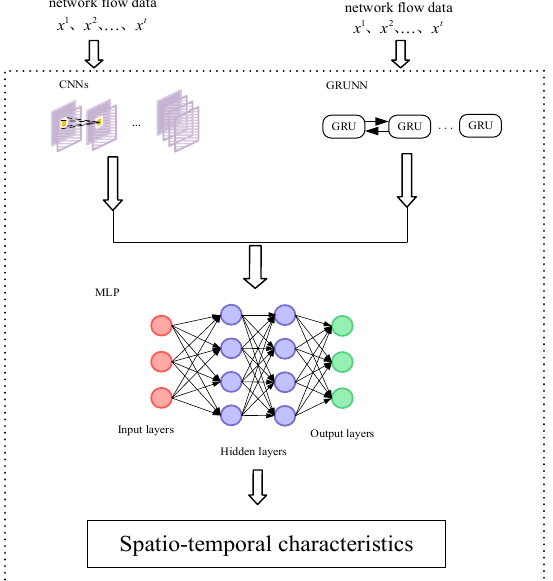
Figure 4. Encoder structure.